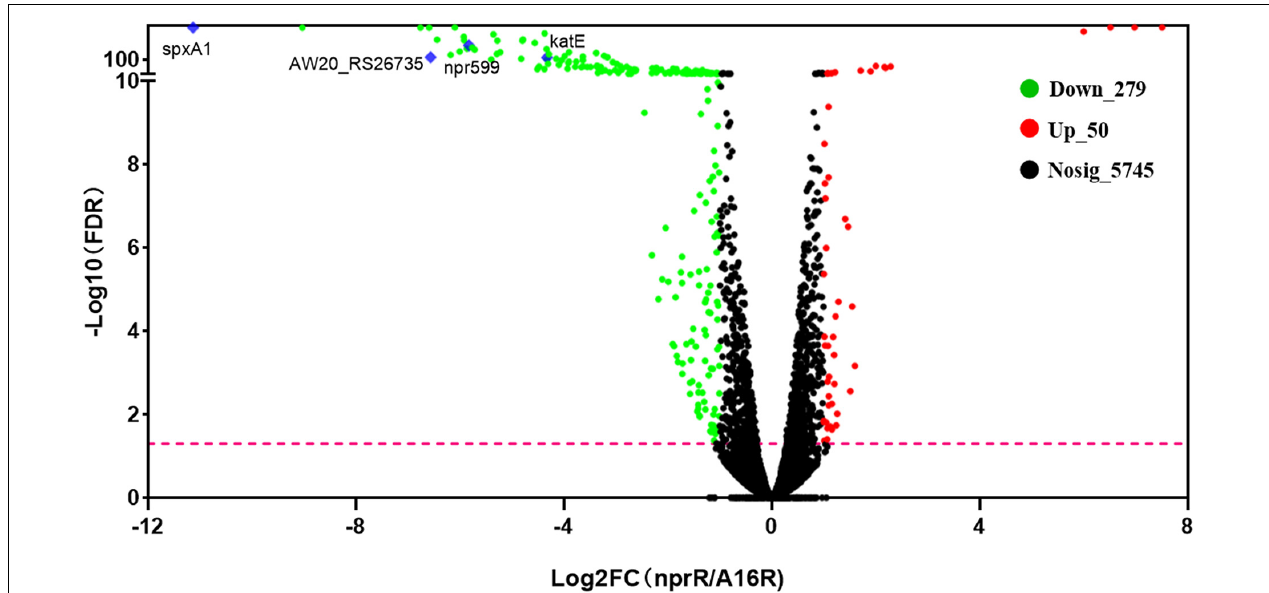
FIGURE 1 | Volcano plots of differentially expressed genes (DEGs). Plots showing log2-fold change (FC) and –log 10 FDR (corrected p -value) values of the DEGs when comparing the RNA-Seq profile of the nprR deletion mutant strain against that of the A16R strain. Green, red, and black points indicate downregulated, upregulated, and non-differentially expressed genes, respectively. The pink line represents FDR = 0.05. Some focused genes also were marked by blue diamond.